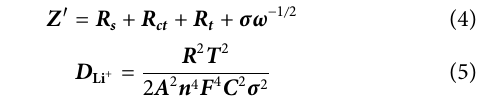
Frontiers in Chemistry |